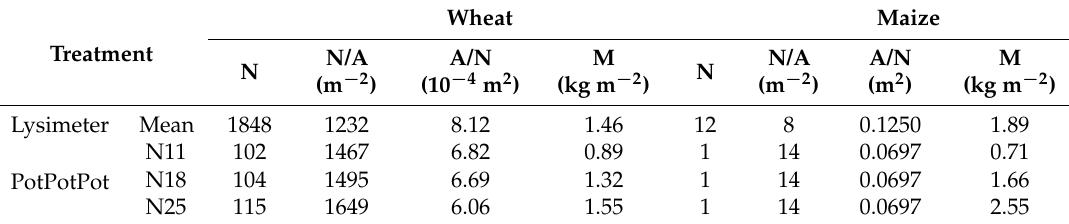
Table 2. Comparisons of pot and lysimeter crop density levels (N/A), representative areas per plant (A/N), and aboveground dry biomass weights per area for the harvest period (M).